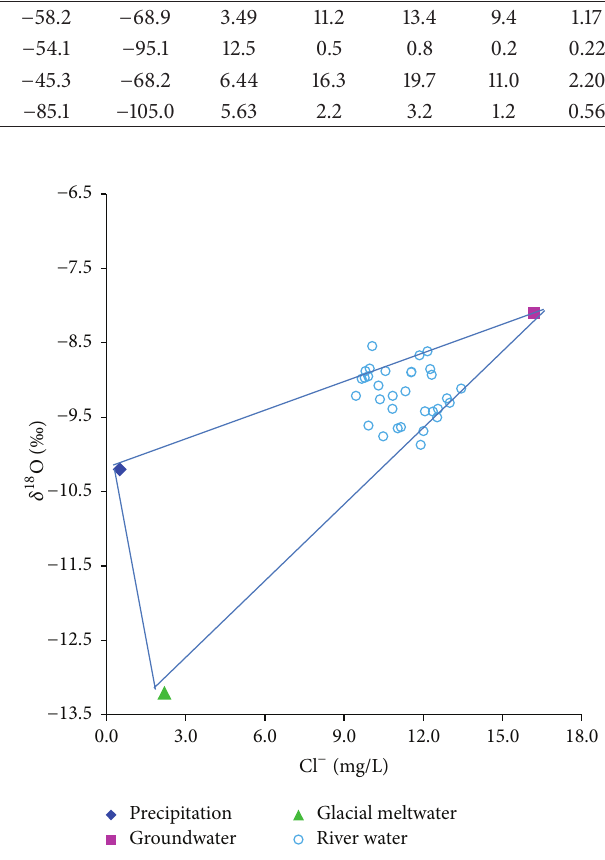
Figure 7: Stream water observations and the average values of tracers Cl − and 18 O of three end members that spanned the